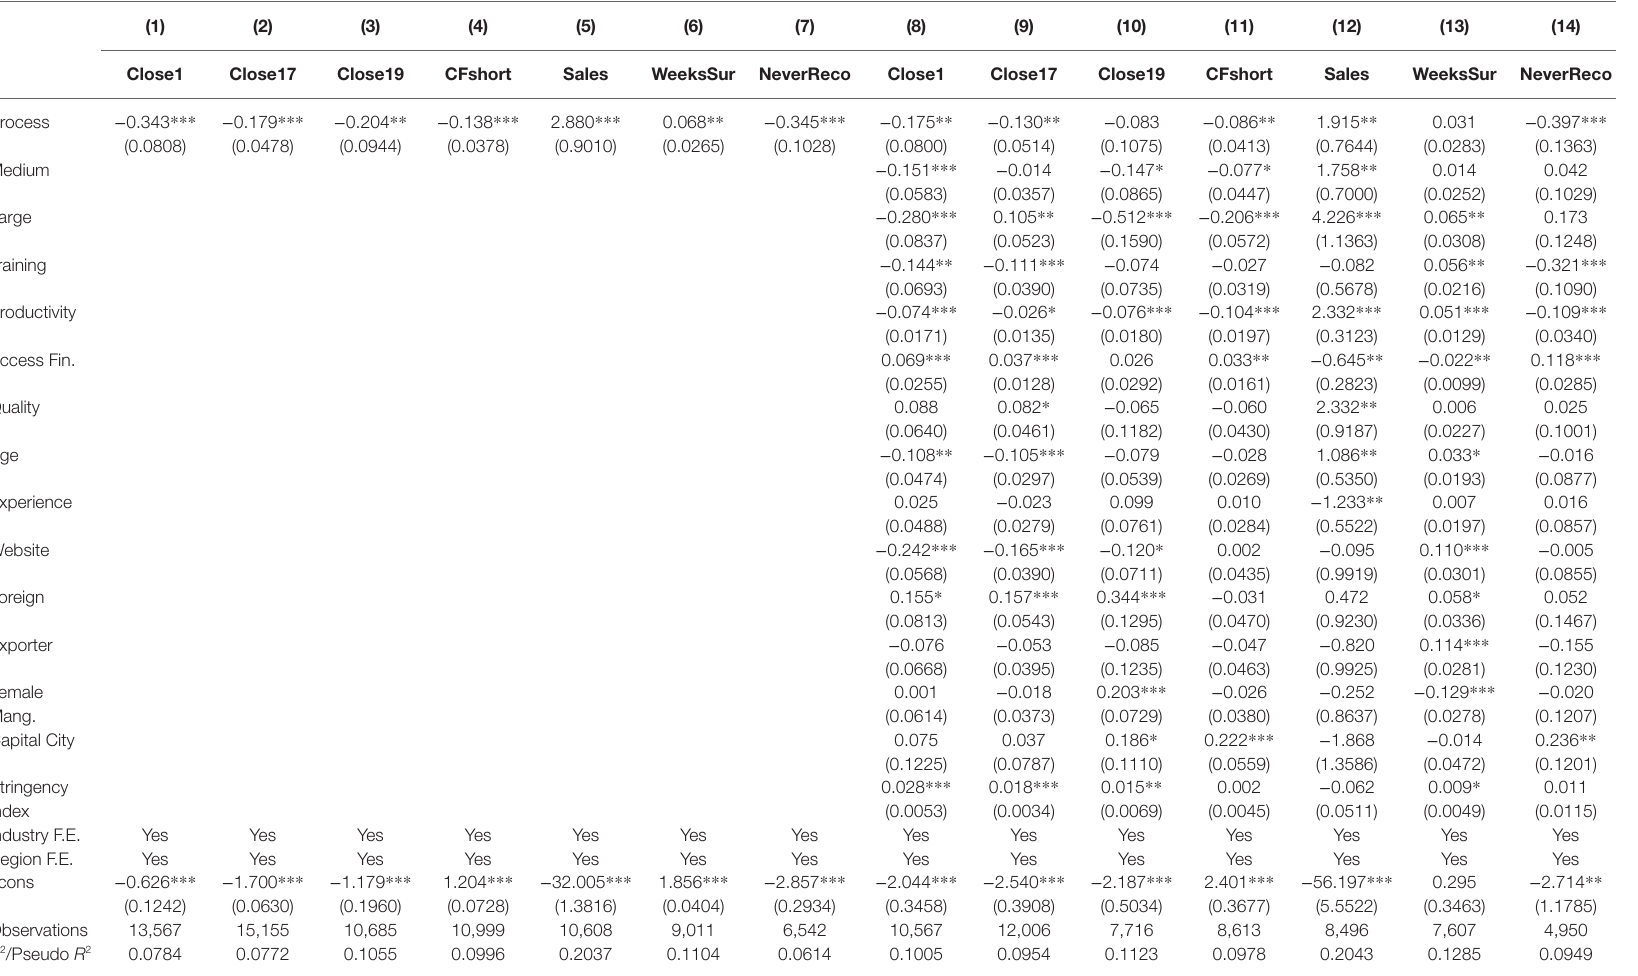
TABLE 3 | Process innovation, closure, performance, and